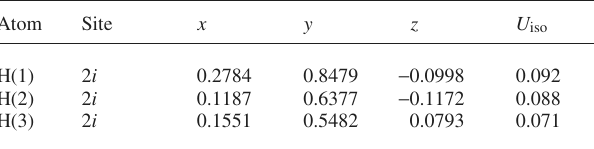
Table 2. Atomic coordinates and displacement parameters (in Å 2 )